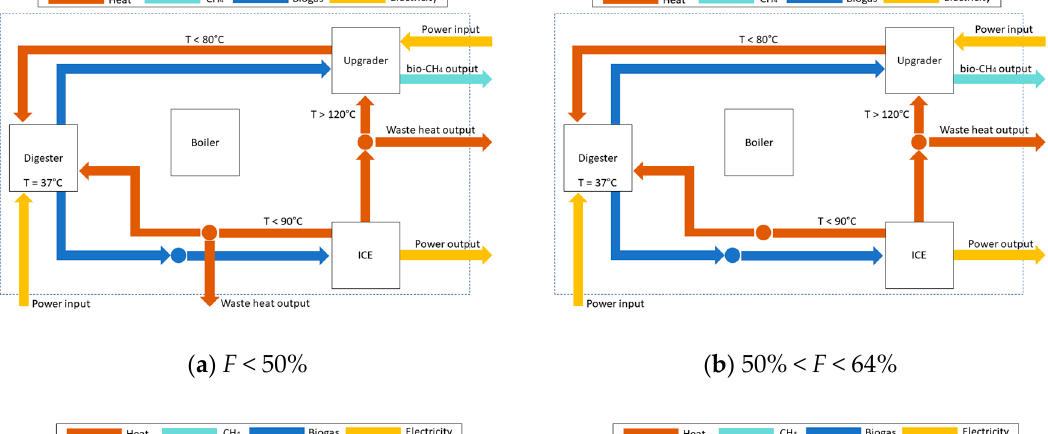
Figure 4. ( a – d ) Heat and mass flows calculated by the simulation.